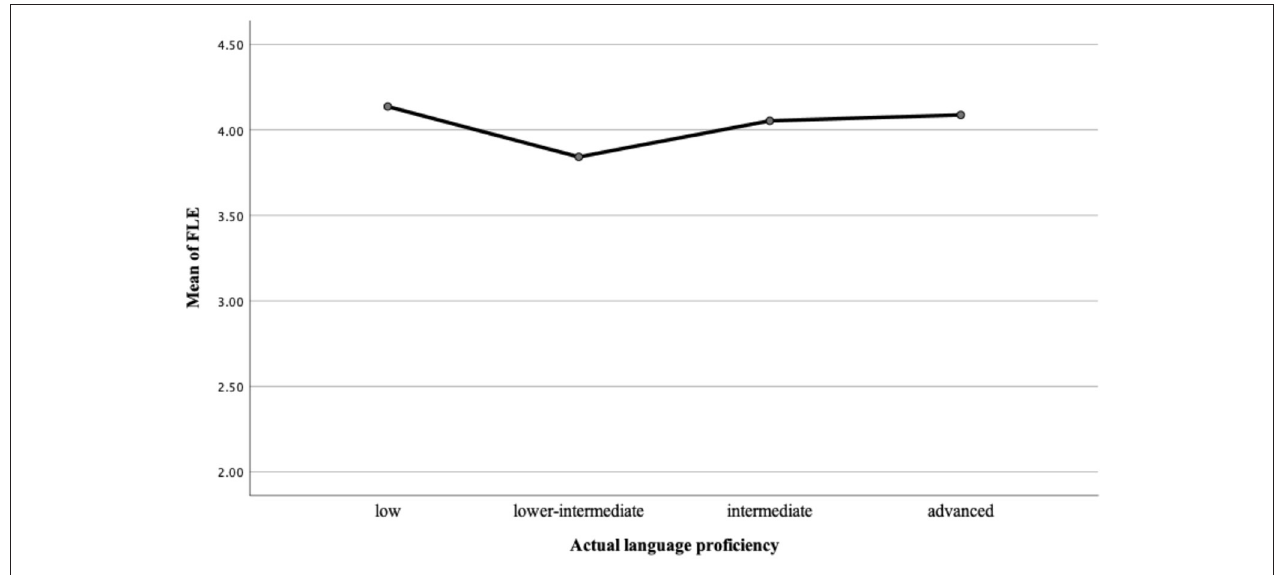
FIGURE 2 | Means of FLE and levels of actual language proficiency.